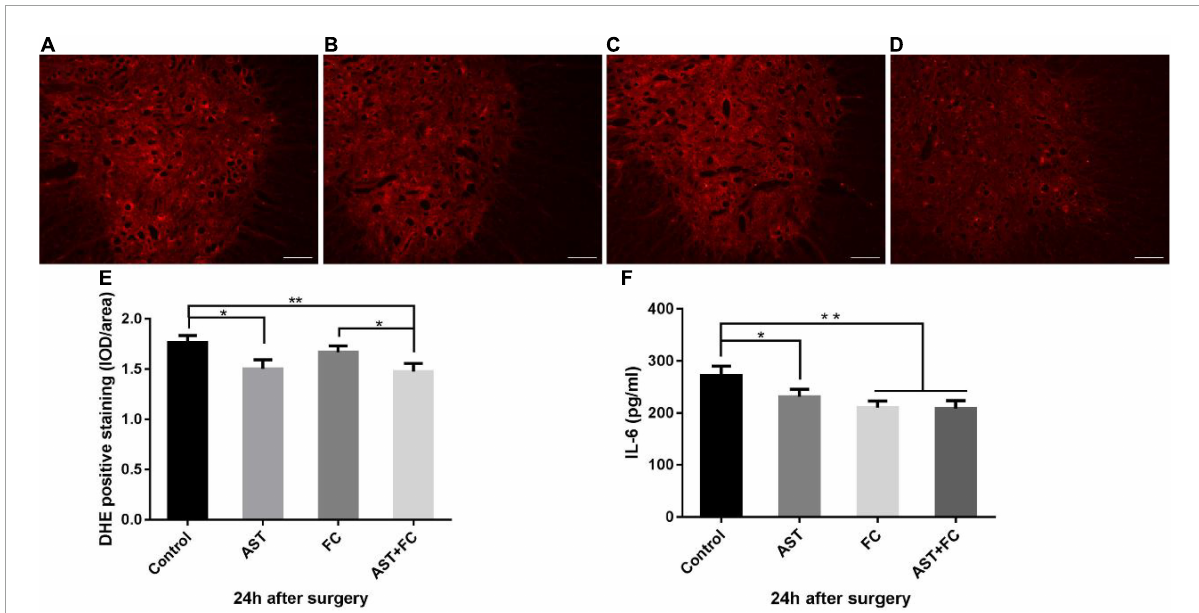
FIGURE2 Fluorescence intensity of DHE and IL-6 levels at 24 h after BPA in the control, AST, FC, and AST + FC groups. (A–D) DHE fluorescence intensity in the anterior horn of the spinal cord at 24 h after BPA and represent the control, AST, FC, and AST + FC groups, respectively (indicated by red areas, bar = 100 µ m). (E) Statistical analysis and comparison of average DHE fluorescence intensities in spinal cord ventral horns in control, AST, FC, and AST + FC groups at 24 h after BPA ( n = 3, * p < 0.05, ** p < 0.01). (F) Statistical analysis and comparison of average IL-6 levels in C5–C7 spinal cord tissues in control, AST, FC, and AST + FC groups at 24 h after BPA ( n = 3, * p < 0.05, ** p <